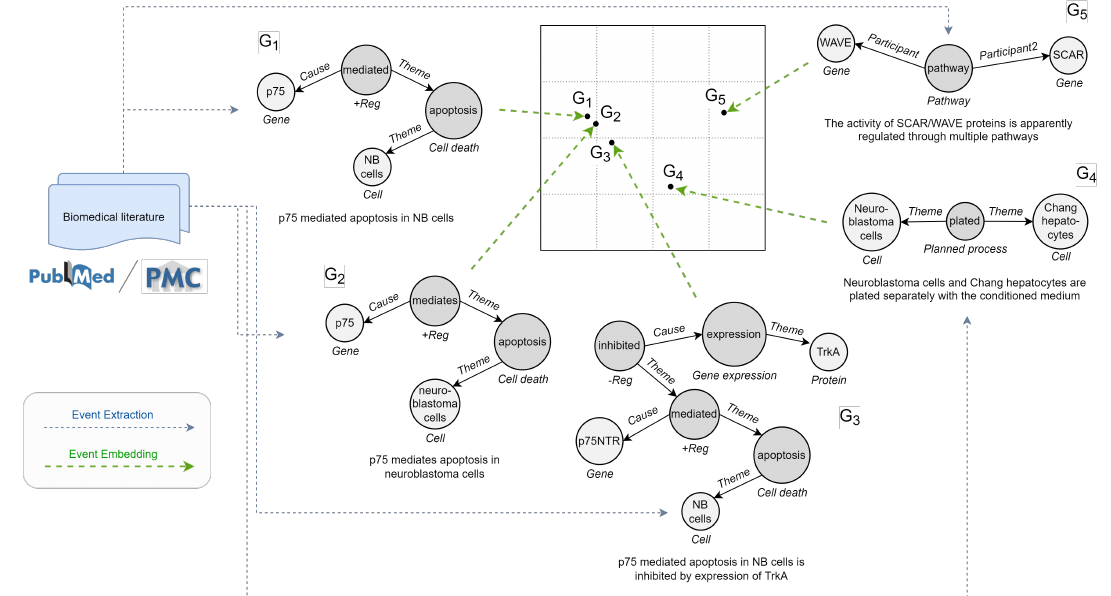
Figure 2. Illustration of similarity-preserving event graph embeddings, with sample events taken from a cancer genetics database (CG13). Each event graph—for which is shown also the textual mention—is mapped into an embedding vector (denoted as a dot in the simplified 2D space). The target embedding function should consider both structure and semantics. The example reports some interesting cases: (i) graphs with same structure and overall semantics ( G 1 and G 2 ), where NB is the acronym for neuro-blastoma; (ii) graphs with different structure but similar semantics ( G 2 and G 3 ), where the process represented by G 2 is contained in G 3 ; (iii) graphs with same structure but different semantics ( G 4 and G 5 ). For precision, we underline that our embeddings are not calculated directly from the raw literature but from events mentioned in abstracts or full texts, mainly obtainable from existing annotations or predictions of event extraction systems (blue